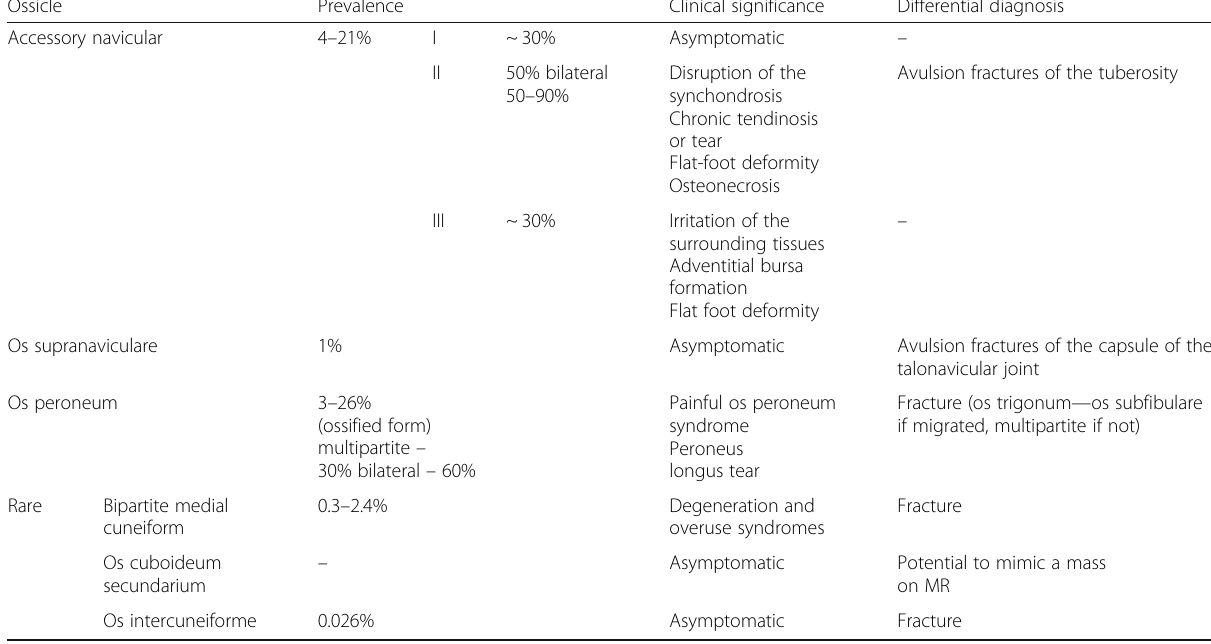
Table 1 Prevalence, clinical significance, and differential diagnosis of the most common types of variants and accessory ossicles in the midfoot